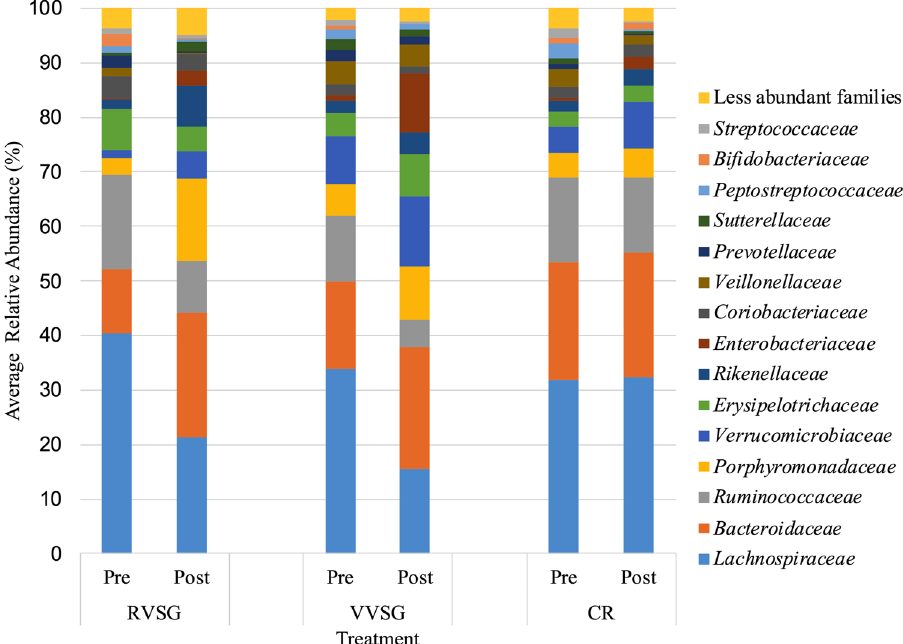
Figure 2. Distribution of family averaged among all patients within treatment groups (RVSG, VVSG, and CR) prior to and post-intervention. There was a significant reduction in members of the Lachnospiraceae family ( P = 0.034) and an expansion in members of the Porphyromonadaceae family ( P < 0.0001) among patients in the RVSG cohort. In VVSG, a reduction of Streptococcaceae (post-hoc P = 0.013) was observed, while no significant changes were seen in